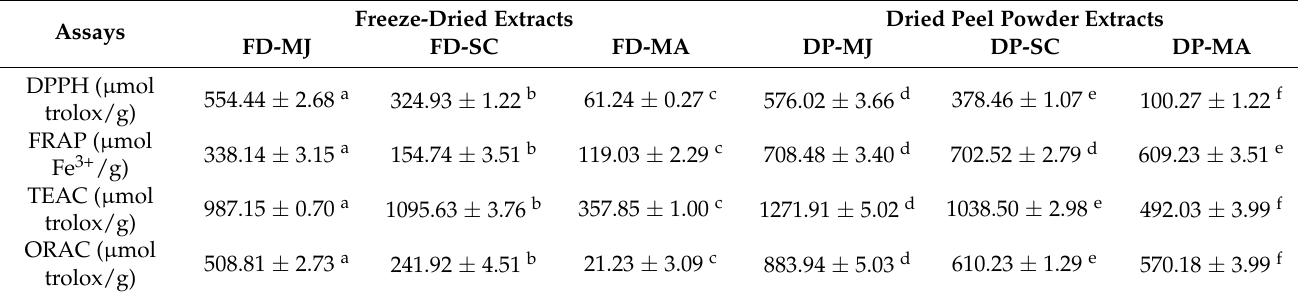
Results are expressed as mean ± standard deviation; a,b,c,d,e,f : means with different letters in the same line are significantly different ( p < 0.05, Tukey’s test). TEAC—Trolox equivalent antioxidant capacity; ORAC—oxygen radical absorbance capacity. DPPH—2,2-diphenyl- 1-picrylhydrazyl, FRAP—Ferric Reducing